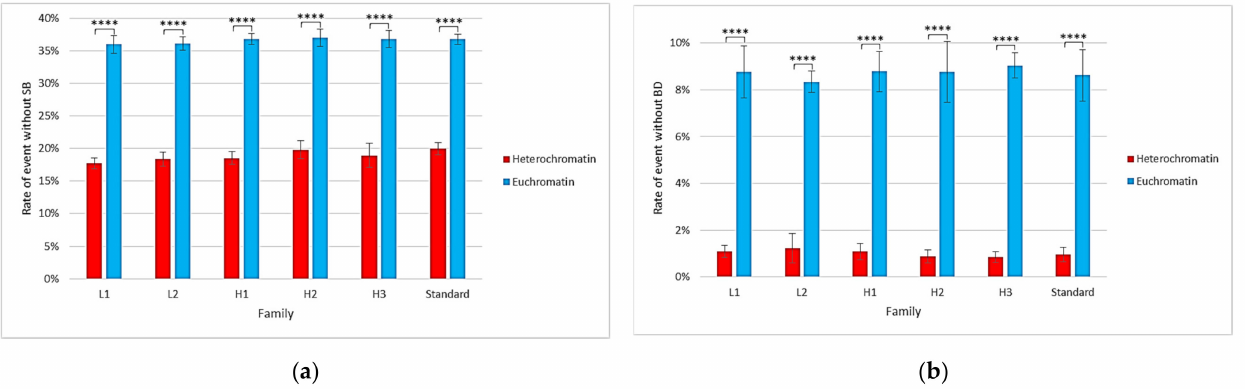
Figure 5. Rate of particle tracks for voxels of different families without induction of ( a ) SB and ( b ) BD. Error bars were obtained with five simulations. Asterisks above the bars represent the degree of confidence on the difference between the two related mean values assessed by Student’s t -test (**** p <